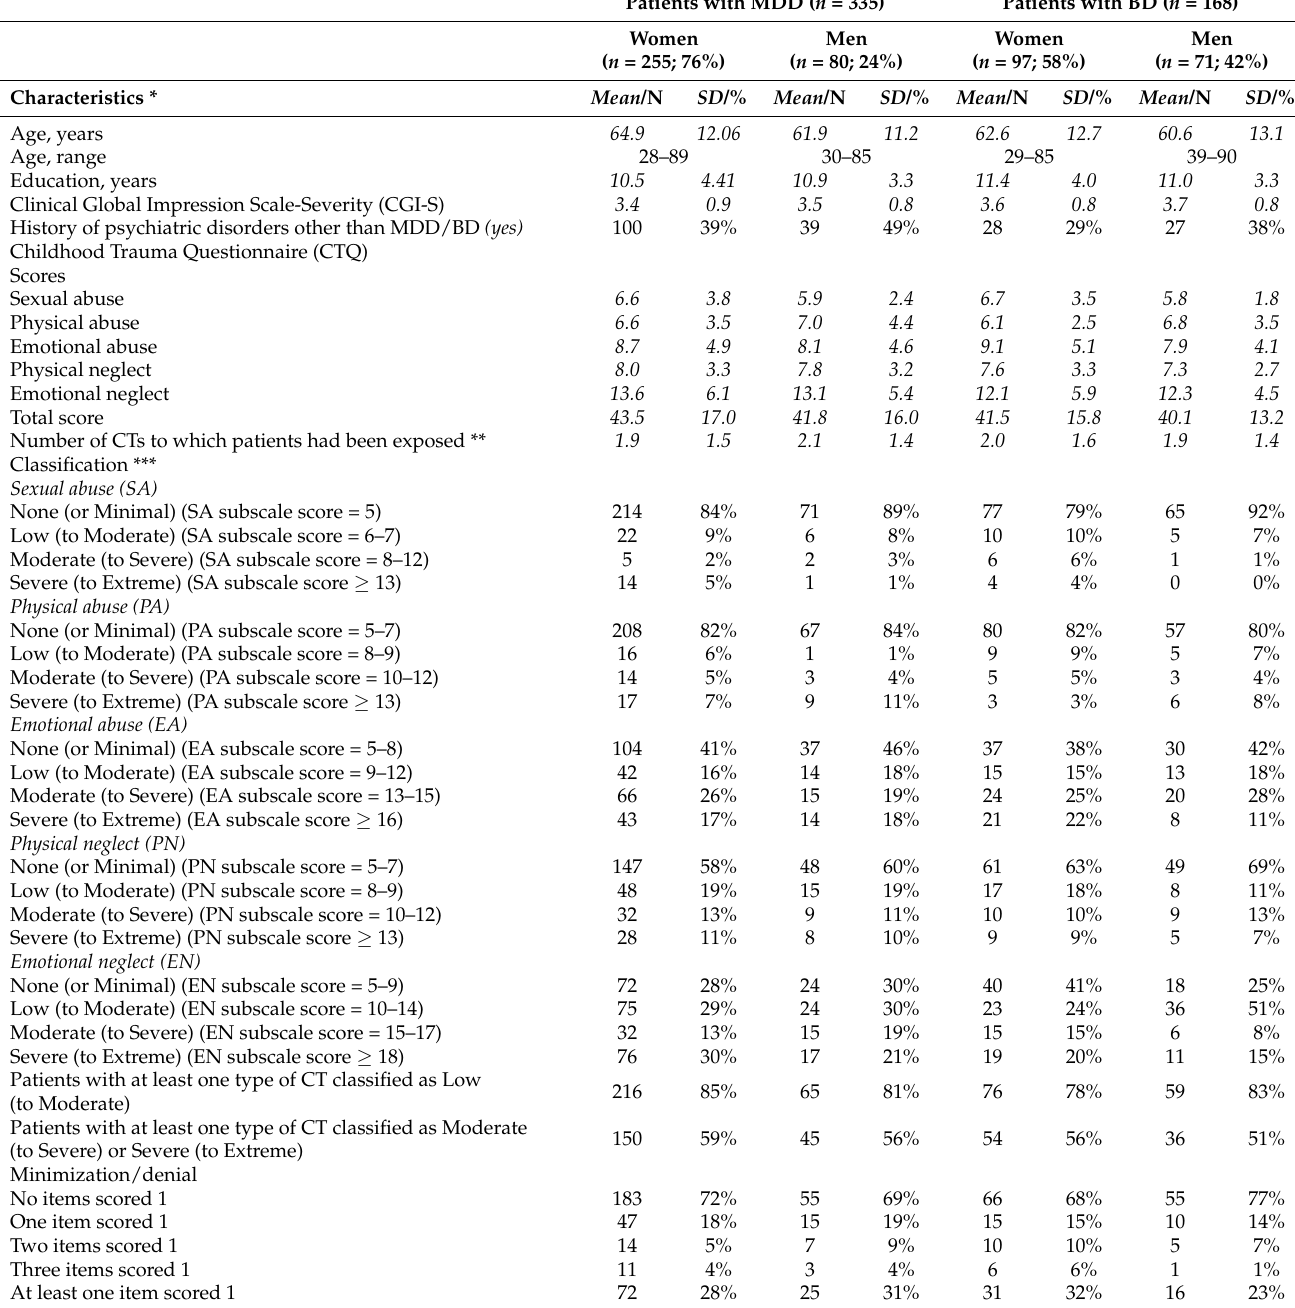
Table 1. Descriptive statistics of women and men in the sample of patients with MDD or